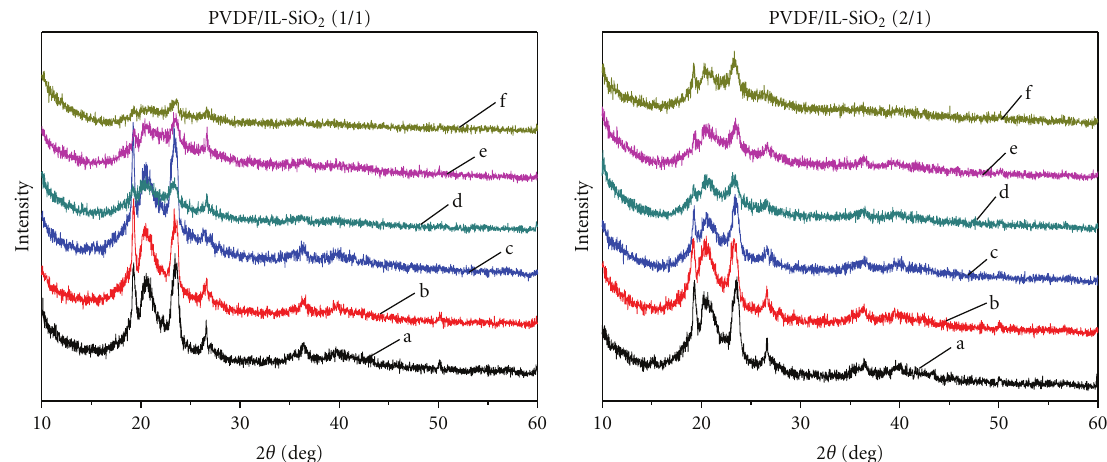
Figure 6: XRD patterns for PVDF/IL-SiO 2 polymer membranes. (a) PVDF/IL-SiO 2 (9:1 by weight). (b) PVDF/IL-SiO 2 (8:2 by weight). (c) PVDF/IL-SiO 2 (7:3 by weight). (d) PVDF/IL-SiO 2 (6: 4 by weight). (e) PVDF/IL-SiO 2 (5:5 by weight). (f) PVDF/IL-SiO 2 (4:6 by weight).